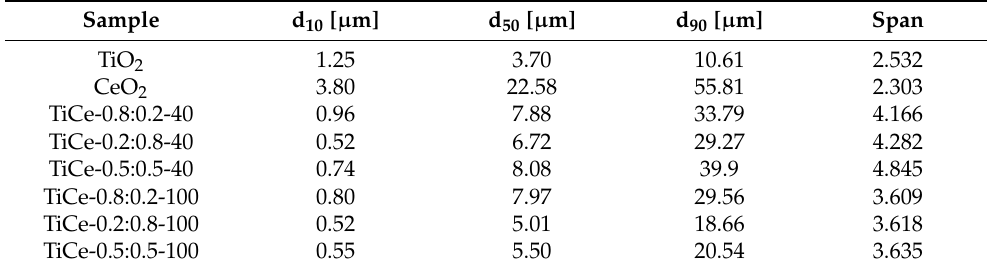
Table 2. The particle size values at 10%, 50%, and 90% of the cumulative frequency and span